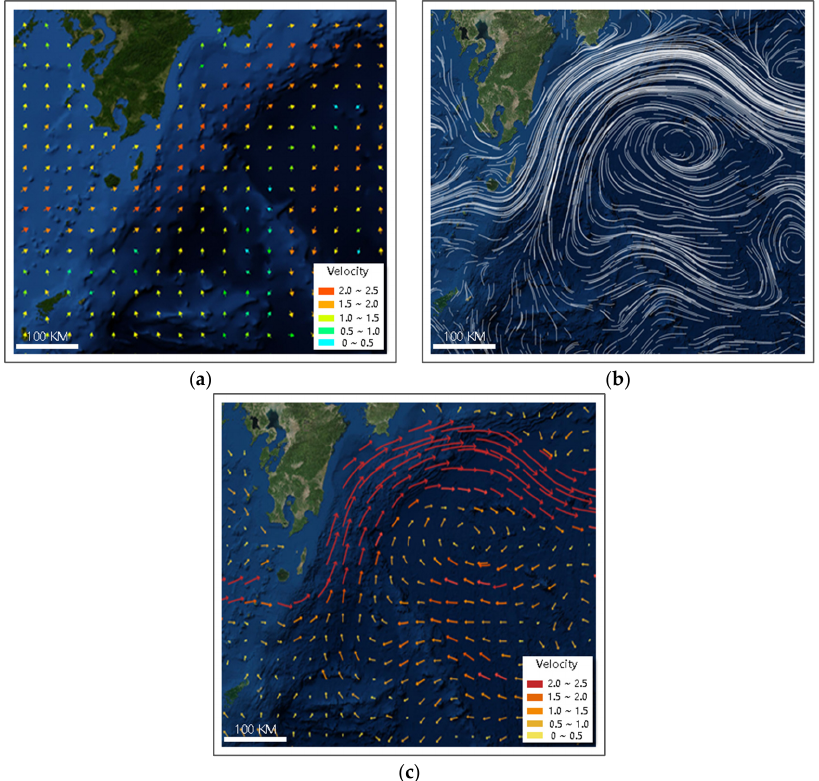
Figure 9. Flow field eddy current e ff ect diagrams generated by three di ff erent mapping methods at the map scale of 1:100,000. ( a ) is the rendering for the direct flow visualization method and the di ff erent color represents di ff erent ranges of velocity, ( b ) is the rendering for the geometric flow visualization method, and ( c ) is the rendering for the multi-scale flow field mapping method based on real-time feature streamlines, the di ff erent color stands for di ff erent ranges of